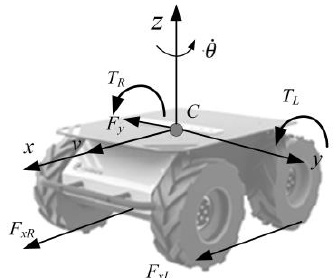
Figure 2. Dynamic model of a skid–steer wheeled robot.